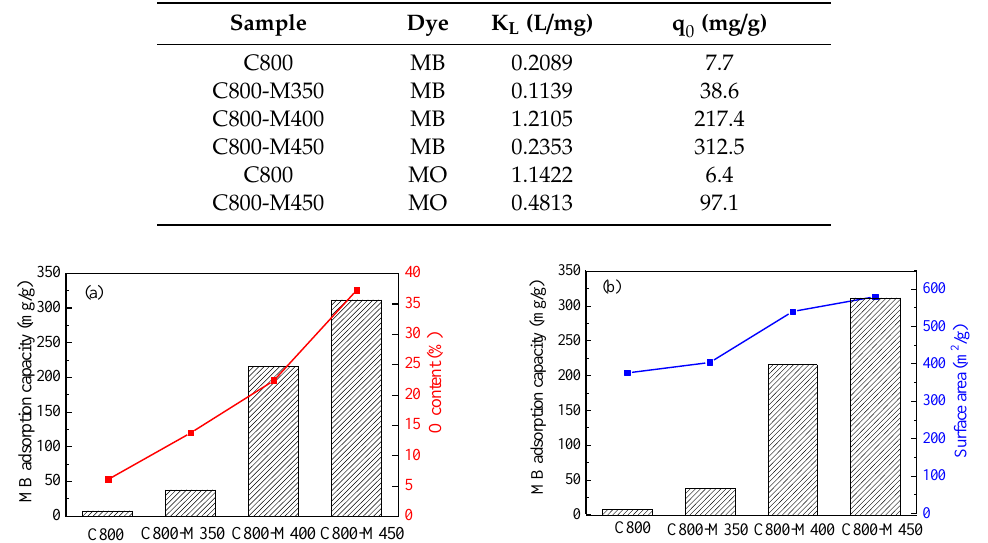
Table3. TheLangmuirisothermparametersfortheadsorptionoforganicdyesontoas-preparedcarbons.